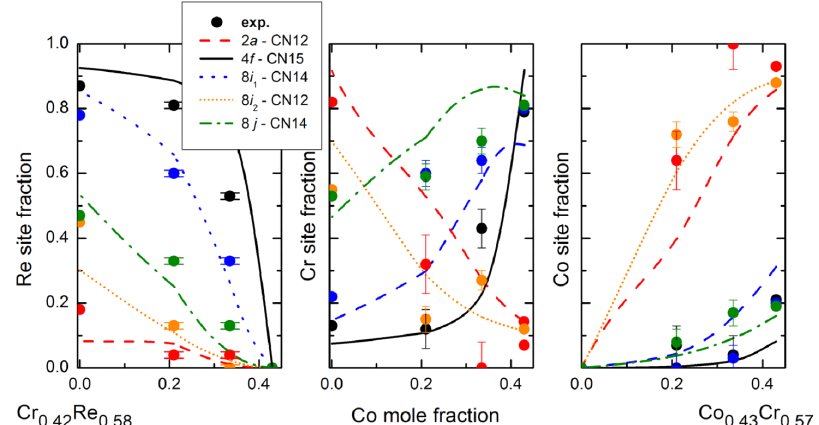
Figure 15. Calculated and experimental site occupancies for the σ phase in the Re–Cr–Co system at 1150 °C along the blue line in Figure 14 (new results). The experimental data for the binary systems are taken from